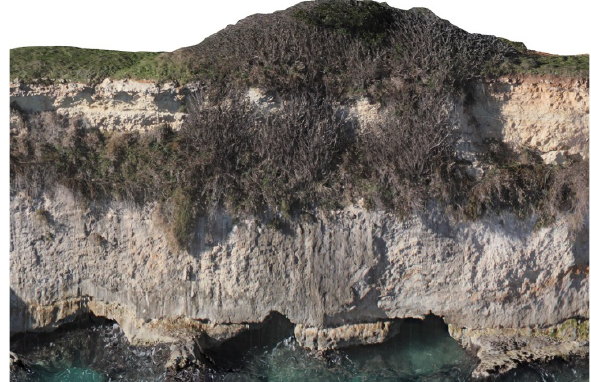
Figure 4. Orthophoto of the study area A (marked in Fig. 3)